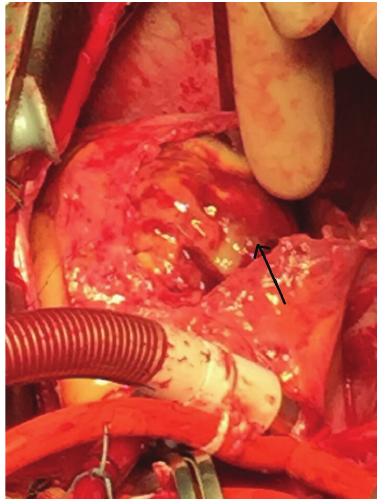
Figure 2: Intracardiac tumor approached through right atriotomy.